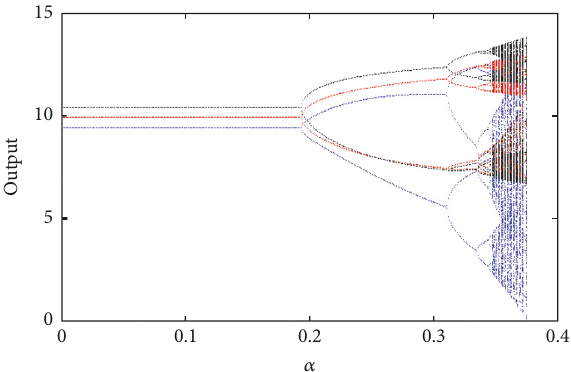
Figure 11: Bifurcation diagram with 𝛼 , 𝛽 = 0.2 and 𝛾 = 0.2 .